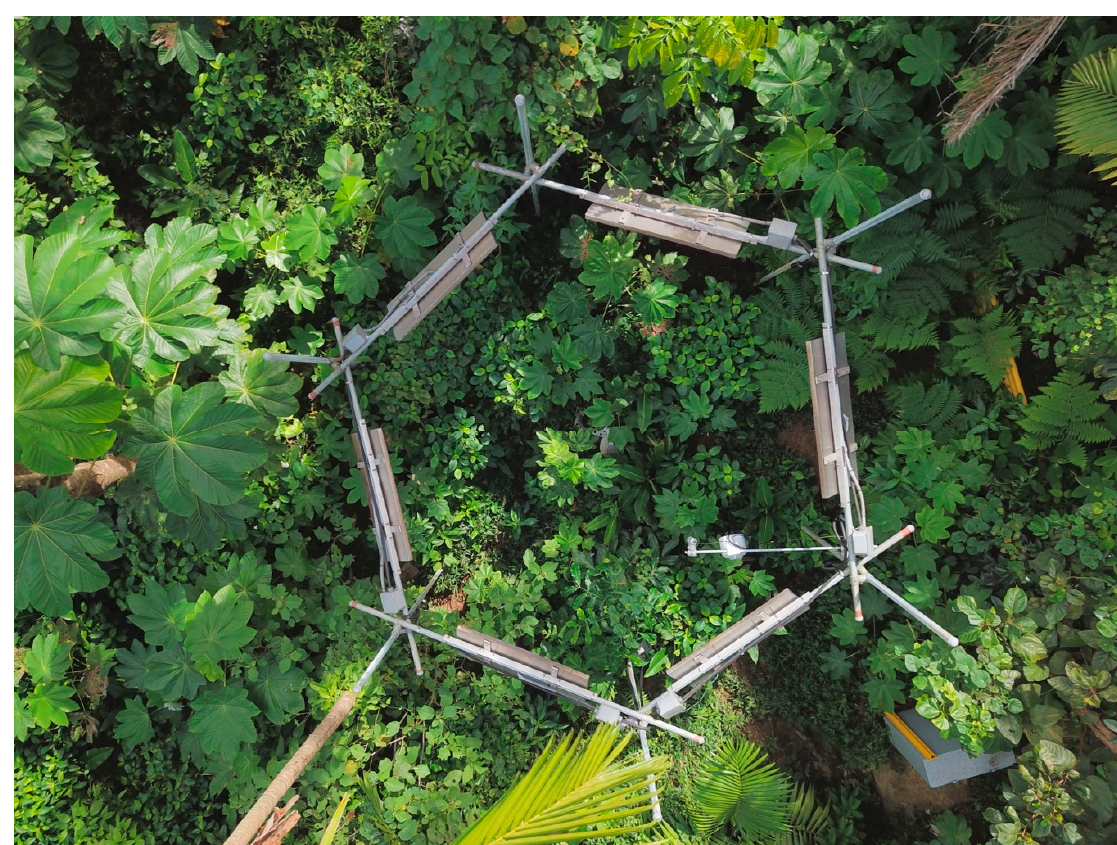
Figure 6. Arial photograph of one of the TRACE plots in 2018, 14 months after Hurricane Maria. 481 Photograph by Maxwell Farrington. 482